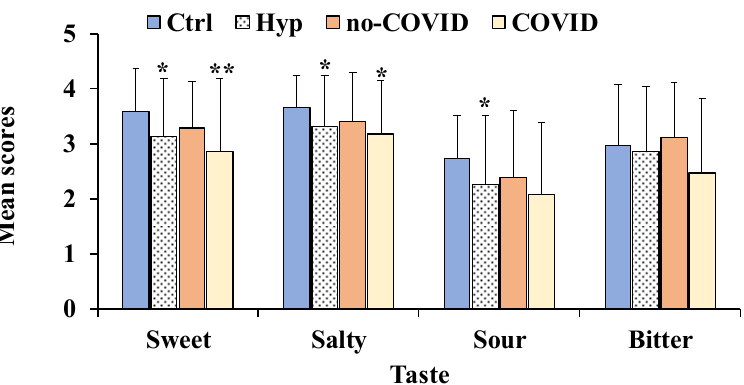
Figure 1. Mean values ± standard deviation of sweet, salty, sour, and bitter taste scores for total patients with hyposmia (Hyp, n = 57), subjects without (no-COVID, n = 34) or with (COVID, n = 23) post-acute Coronavirus Syndrome compared to healthy controls (Ctrl, n = 91). For each taste modality (sweet, salty, sour, and bitter) significant differences were: ** = p < 0.01 and * = p < 0.05 versus Ctrl (One-way ANOVA).